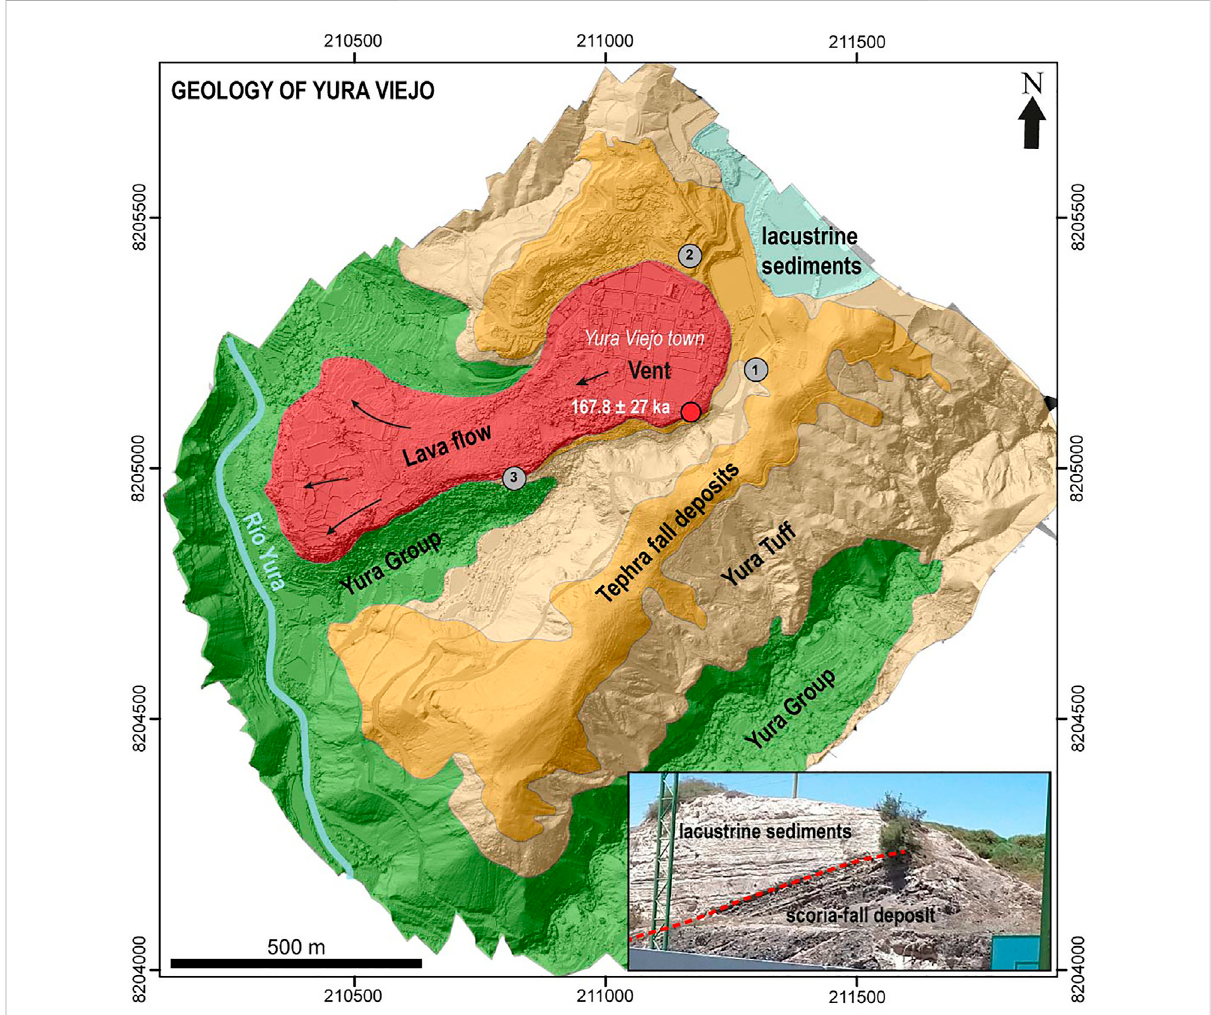
FIGURE 2 Geological map of the Yura Viejo volcano, embedded on a 60-cm resolution digital Elevation Model (DEM) map. Gray numbered dots indicate the location of stratigraphic sections shown in Figure 5. In the lower-right corner, a photograph of tephra fallout beds covered by lacustrine